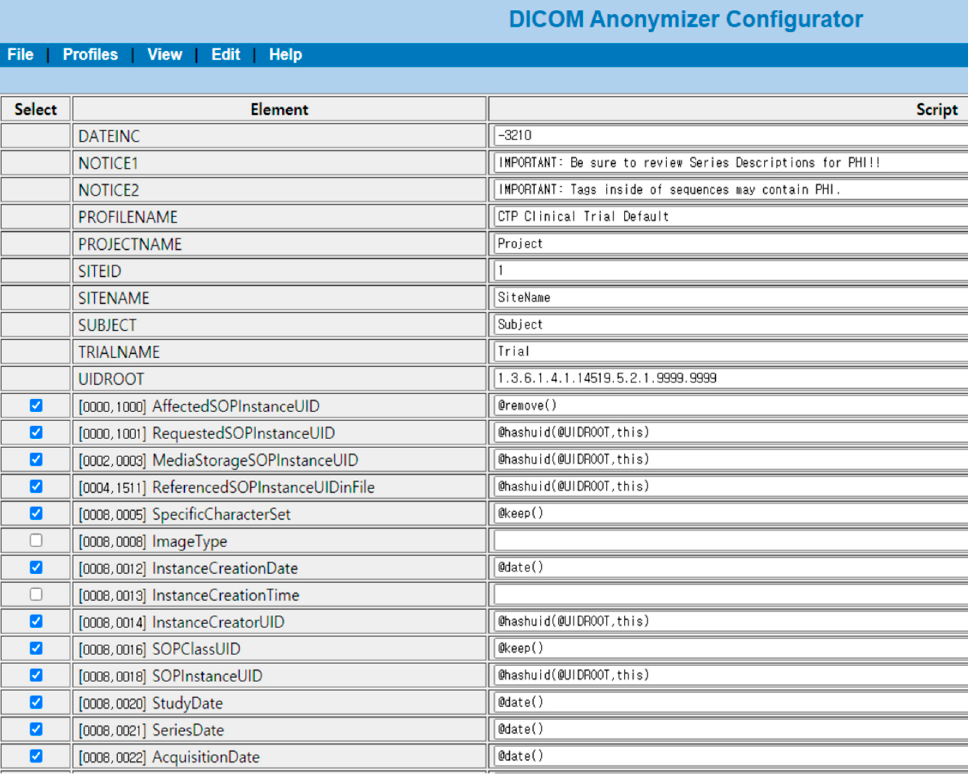
Figure 2. Basic Profile De-Identifier Elements Setting within the Clinical Trial Processor (CTP).